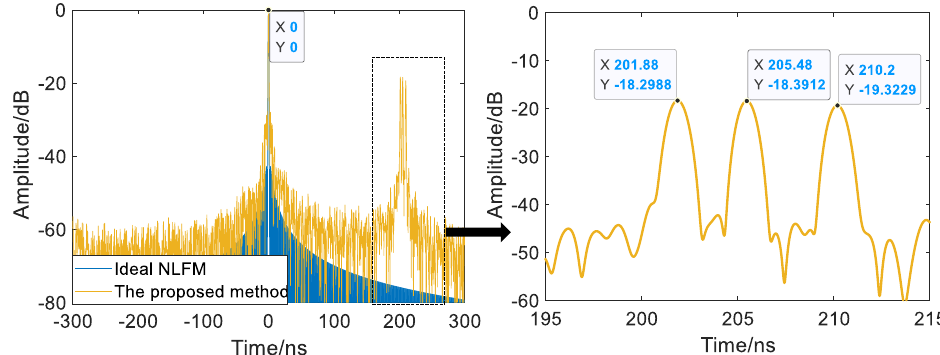
Figure 14. The results of the three-point experiment.